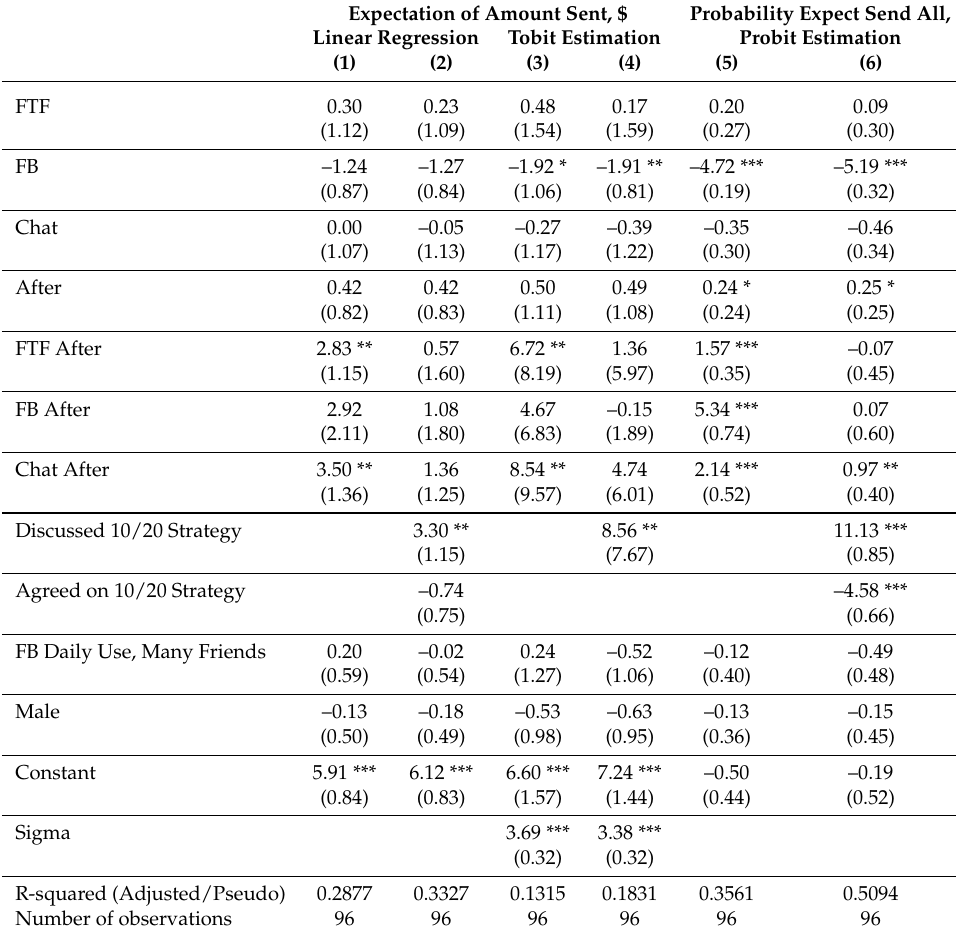
Table 6. Receiver expectation of amount sent: regression